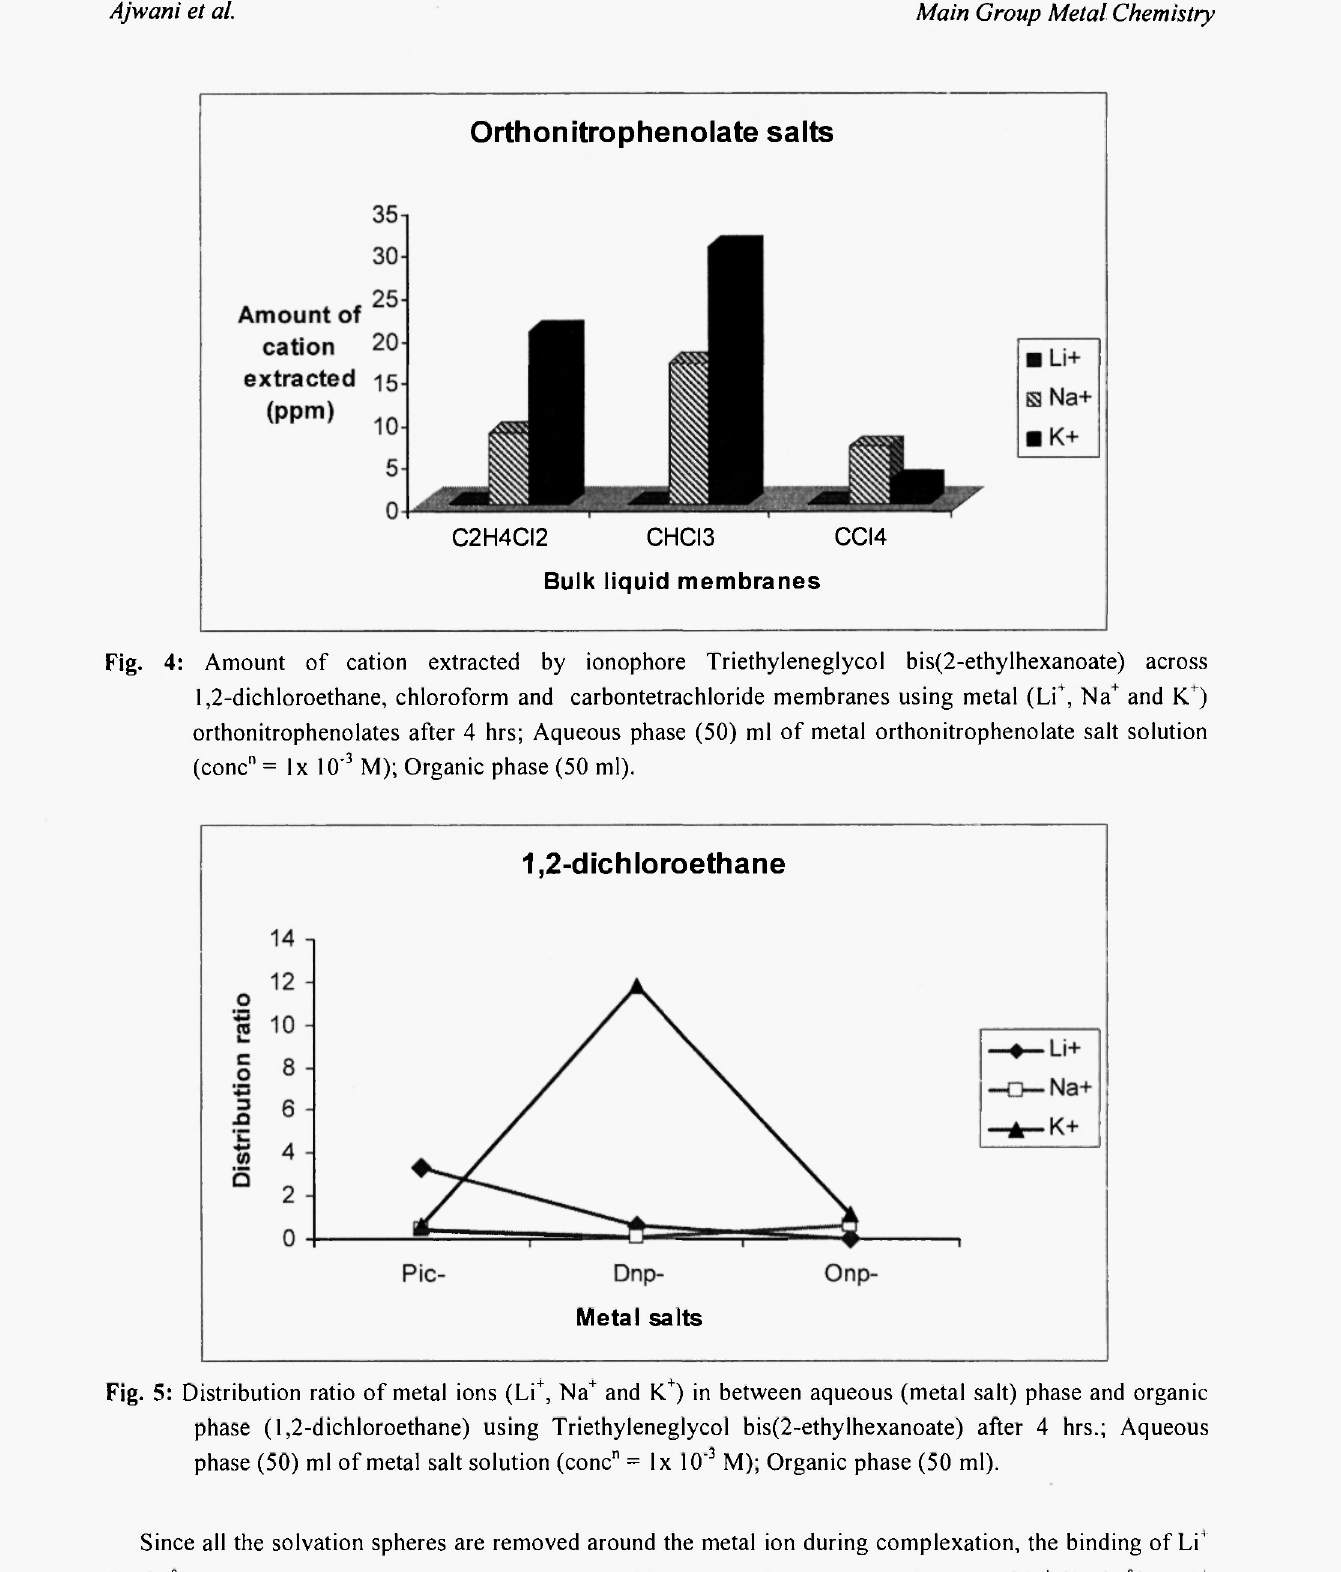
Since all the solvation spheres are removed around the metal ion during complexation, the binding of Li + (1.20 Ä) in the pseudocyclic cavity is very poor, with more preference increasing from Na + (1.90 A) to K + (2.66 A). It suggests that overall specificity and selectivity of the ligand is for K + ; as Li + and Na + are